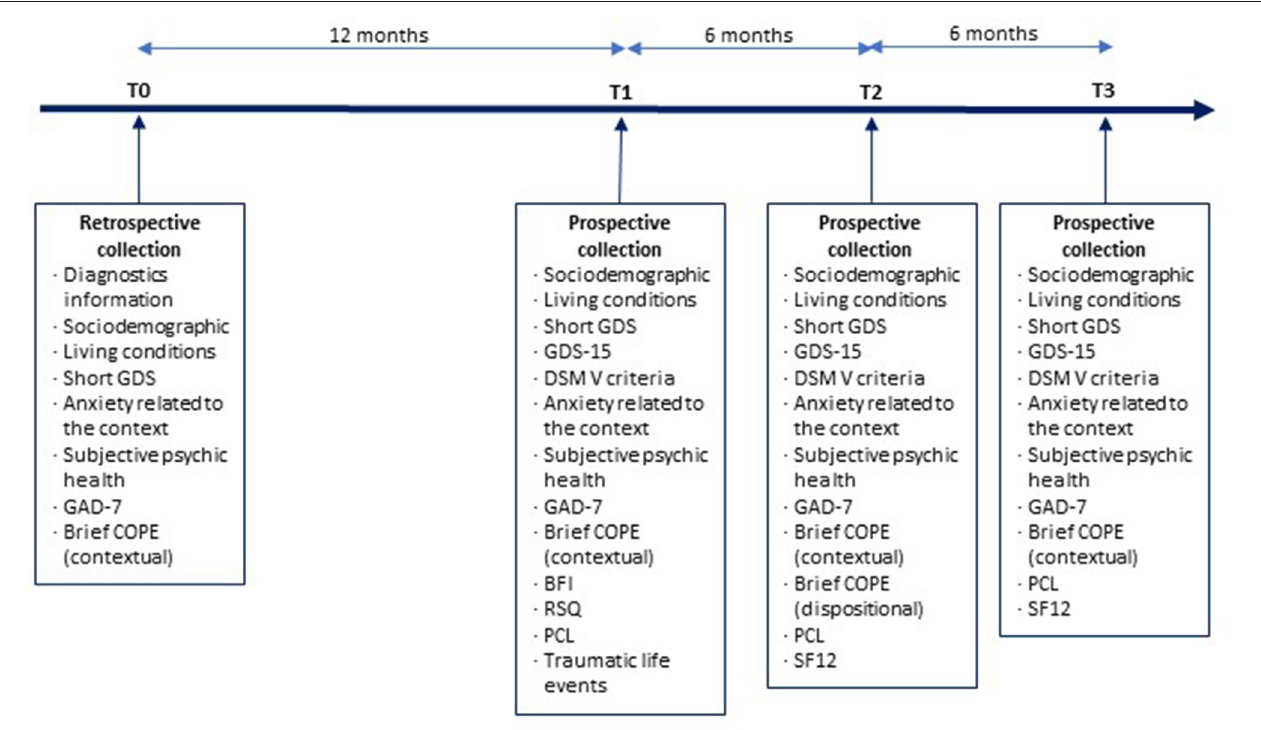
FIGURE 1 | The typical schedule for a patient enrolled in the STERACOVID protocol: a summary of the distinct stages.